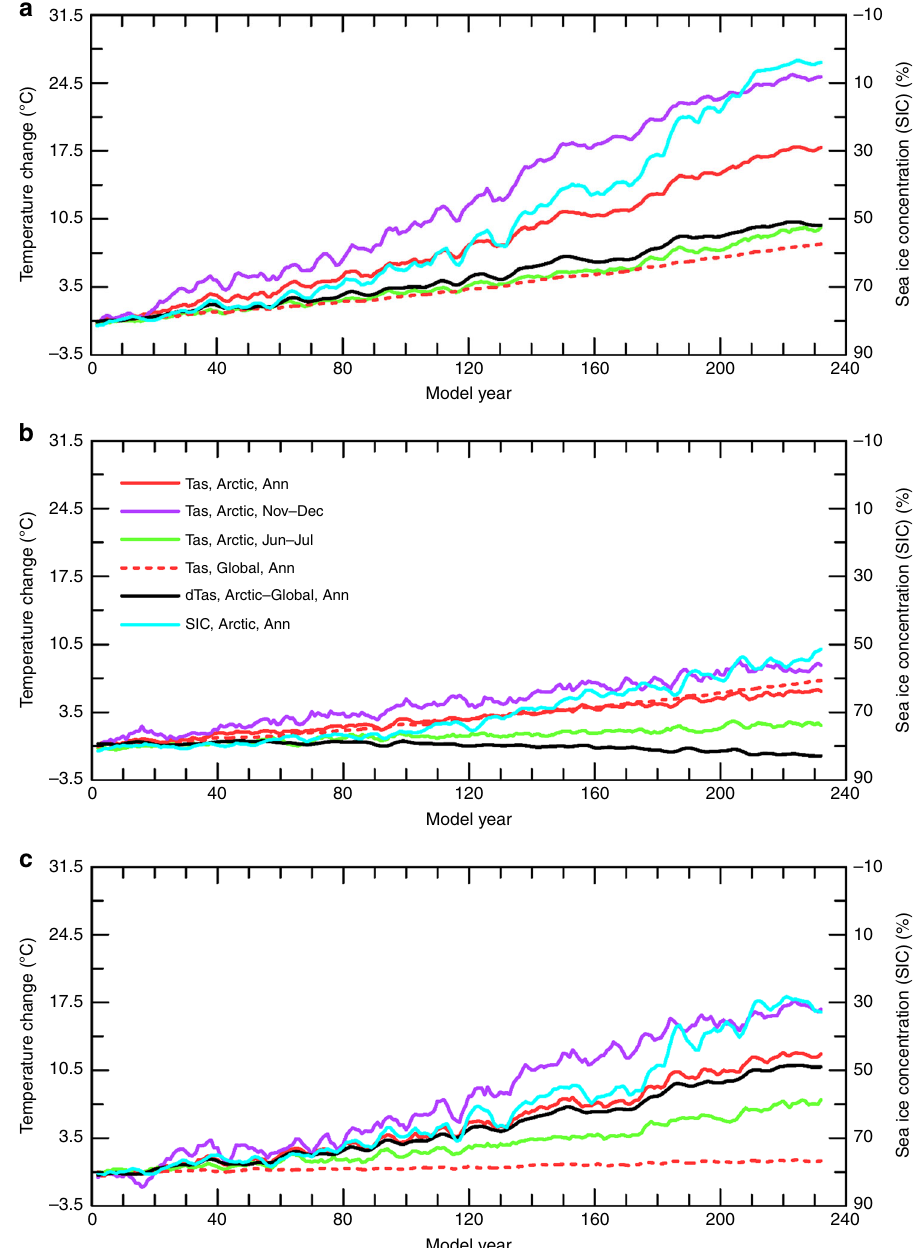
Fig. 6 Time series of CESM1-simulated changes in surface air temperature (Tas) and sea-ice over the Arctic (67°-90°N) and globe. a Standard 1% CO 2 run, b FixedIce run, and c their difference (panel a minus panel b ). Shown are the annual (solid red), November – December (magenta), and June – July (green) mean Tas, and annual Arctic sea-ice concentration (blue, right y-axis, increase downward), together with the Arctic-minus-global annual Tas difference (black). The change is relative to the control-run climatology and fi ve-year averaging is applied. Note that global Tas changes for November – December